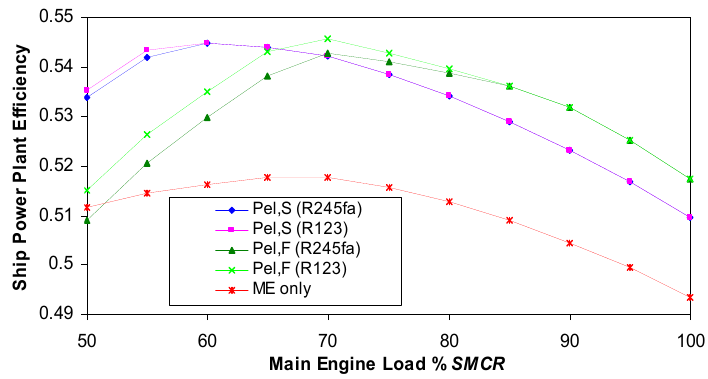
Figure 19. Ship Power Plant Efficiency with organic fluids— η P,ship (power only).